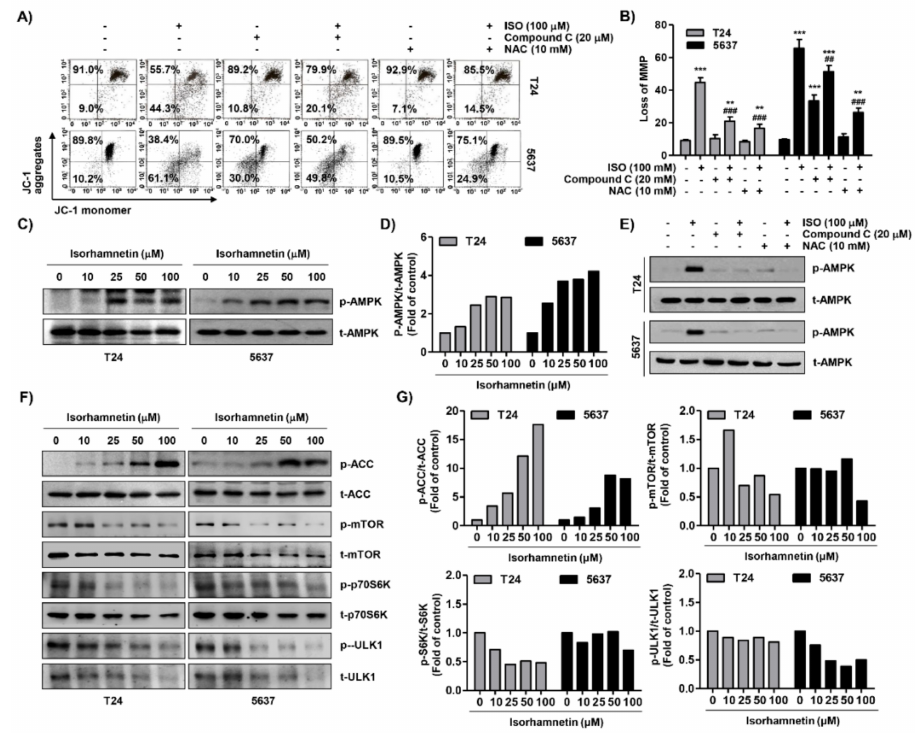
Figure 6. Mitochondrial dysfunction and activation of adenosine 5 (cid:48) -monophosphate-activated protein kinase (AMPK) signaling pathway using isorhamnetin in bladder cancer cells. ( A , B ) Cells were treated with 100 µ M isorhamnetin for 48 h, or pre-treated with 20 µ M compound C or 10 mM NAC for 1 h before isorhamnetin treatment for 48 h. (A) The cells were stained with 5,5 (cid:48) ,6,6 (cid:48) -tetrachloro-1,1 (cid:48) ,3,3 (cid:48) -tetraethylimidacarbocyanine iodide (JC-1) dye, and were then analyzed using flow cytometry in order to evaluate the changes in mitochondrial membrane potential (MMP). ( B ) Each bar represents the percentage of cells with JC-1 monomers (mean ± SD of triplicate determinations, ** p < 0.001 and *** p < 0.0001 compared to the control; ## p < 0.001 and ### p < 0.0001 compared to the isorhamnetin-treated cells). ( C , F ) After treatment with the indicated concentrations of isorhamnetin for 48 h, total cell lysates were prepared and Western blotting was then performed using the indicated antibodies and an ECL detection system. ( D , G ) The expression of each protein was indicated as a fold change relative to the control. Quantitative analysis of mean pixel density was performed using the ImageJ ® software. ( E ) The cells cultured under the same conditions as A and B were collected, and Western blotting was then